Question: Identify the chart type used in this figure.
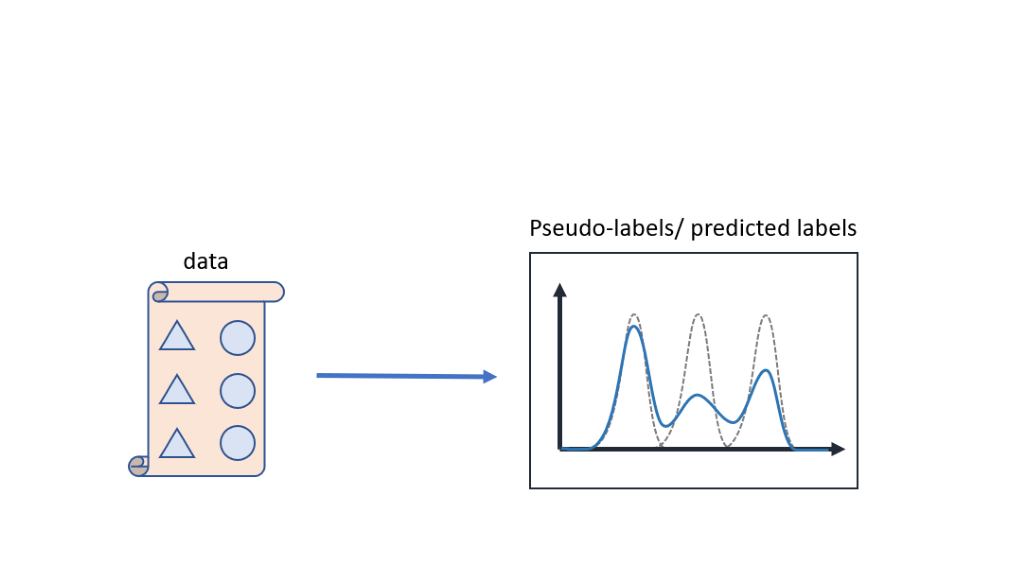
Answer: line